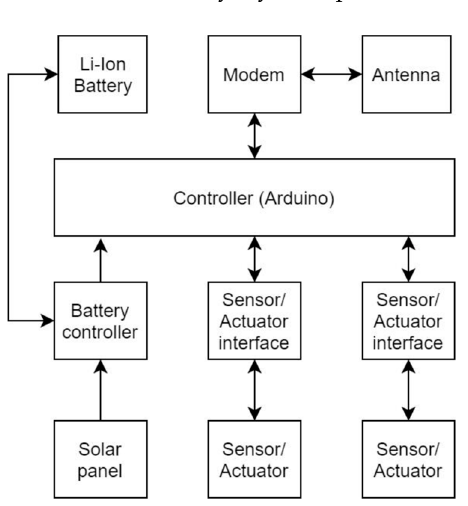
Figure 1. IoT node architecture.